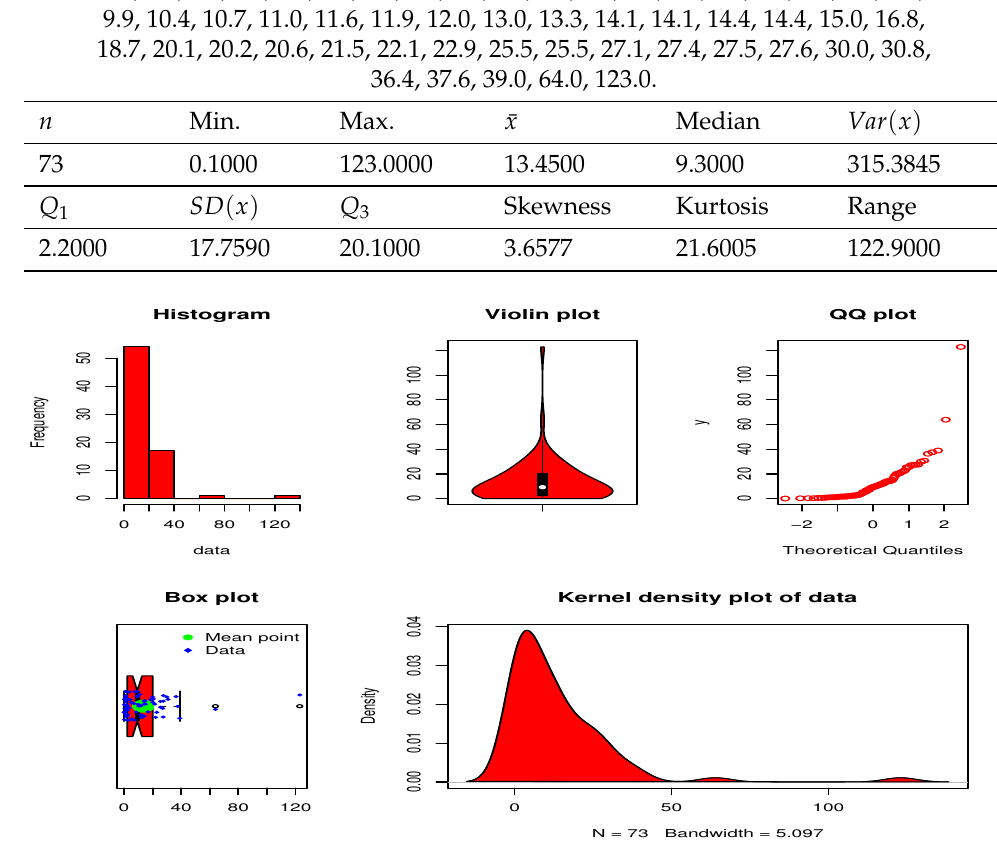
Figure 9. Visual description of the flood peaks data